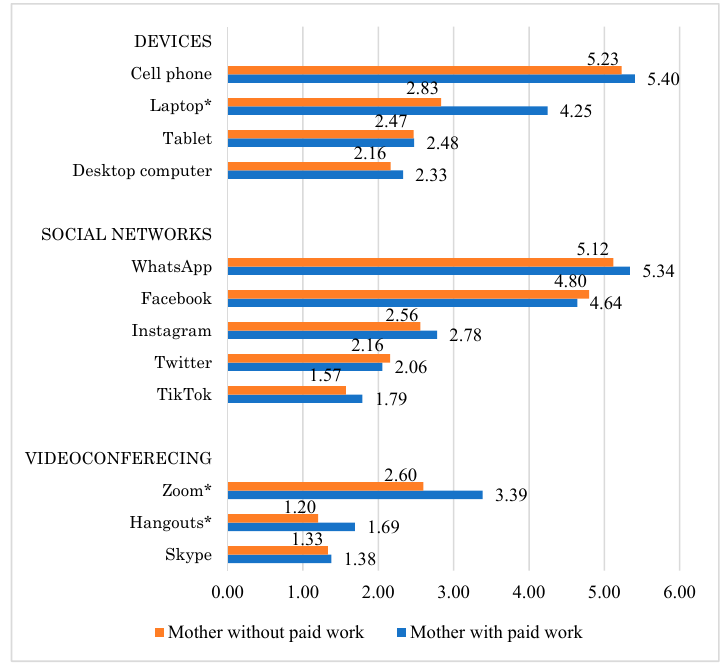
Figure 1. Use of ICTs by mothers with and without paid work. * p ≤ 0.002.